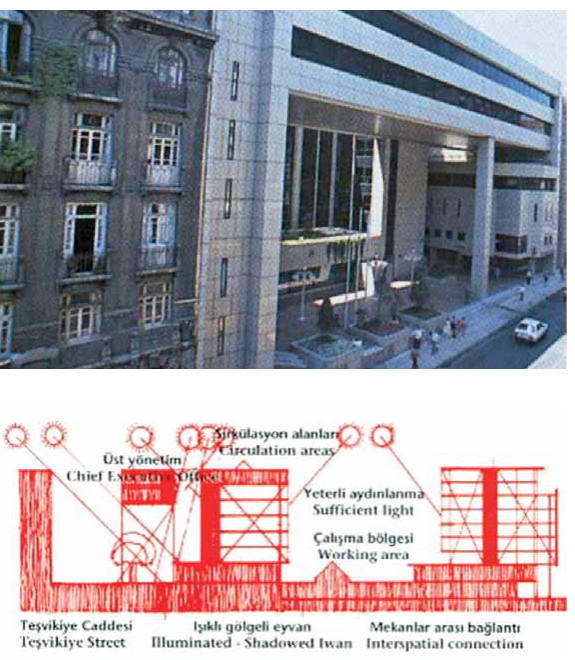
fig. 13. national reinsurance Building and its section